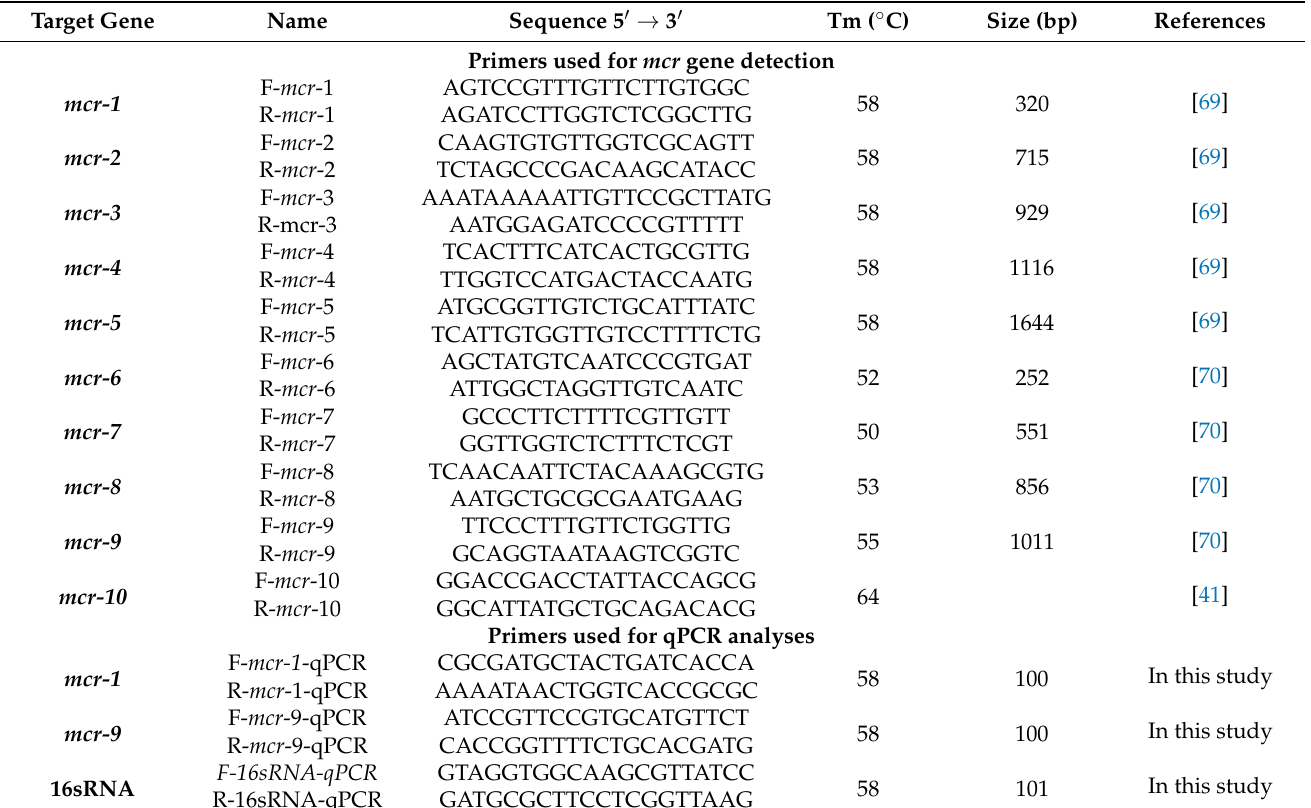
Table 4. Oligonucleotide primers used in this study and their target